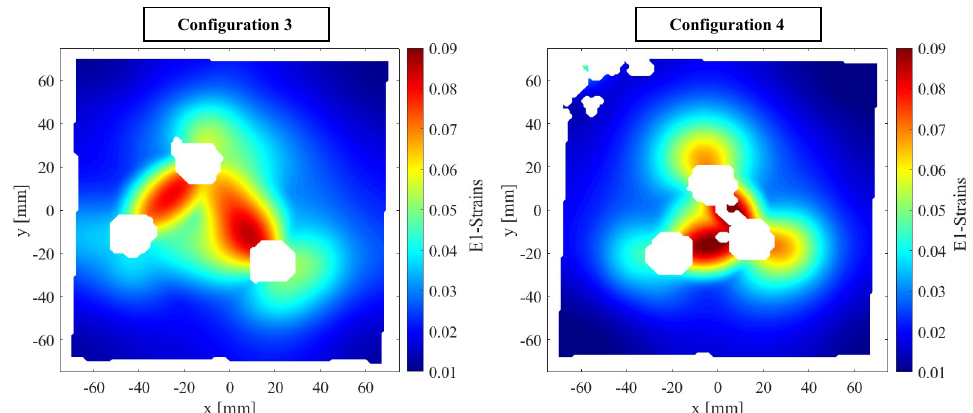
Figure 21. Illustration of the major principal strains for blast-loaded aluminum plate (configurations 3 and 4), highlighting strain concentration zones and crack